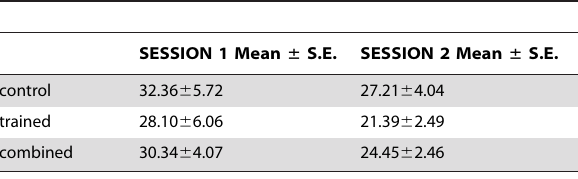
Table 1. Measures of vocal stability in simple singing in both groups at each timepoint.